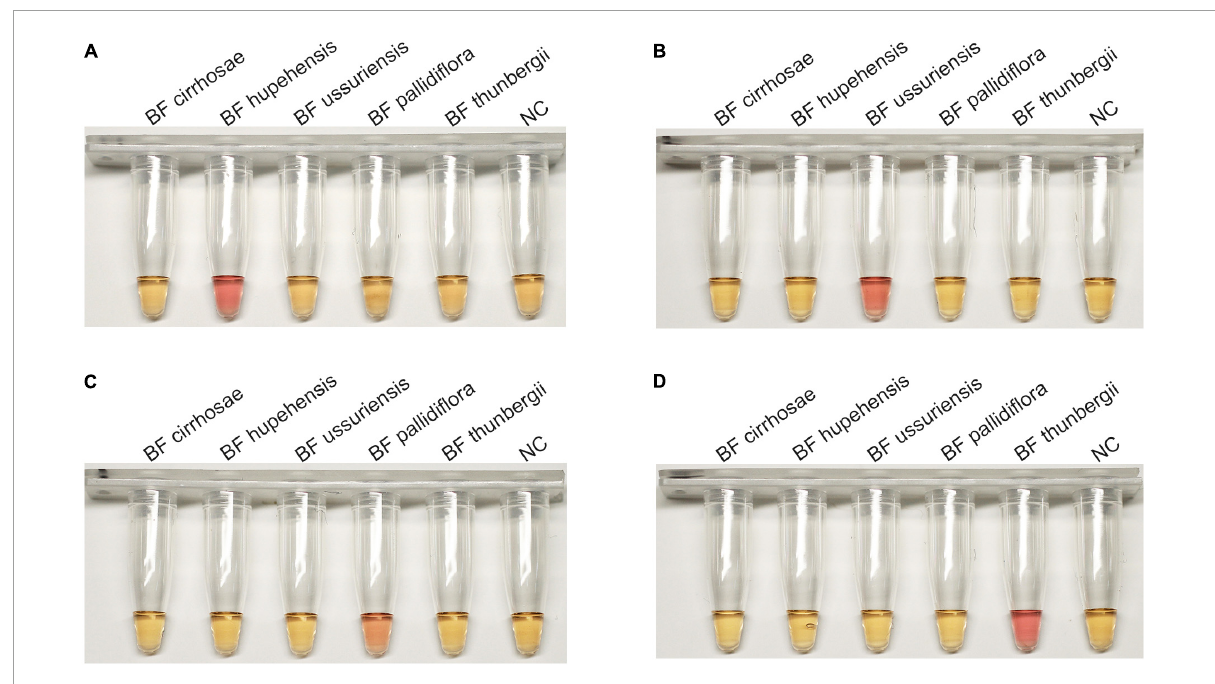
FIGURE6 The colorimetric detection of four BF by using N-red reporter in Recombinase Assisted Loop-mediated isothermal DNA Amplification system. (A) BF hupehensis. (B) BF ussuriensis. (C) BF pallidiflora. (D) BF